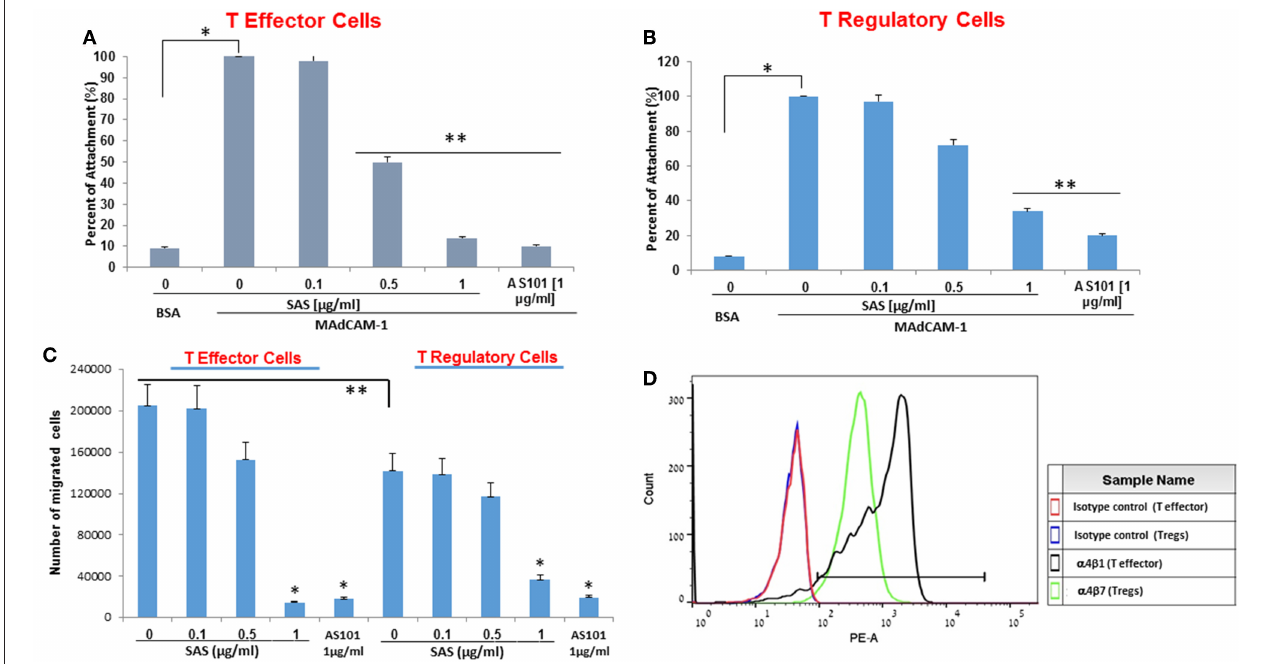
FIGURE 12 | AS101 and SAS inhibit α 4 β 7 integrin activity and α 4 β 7-depenfent migration of T effector cells and Tregs. (A) T effector cells and (B) T regulatory cells were isolated from spleens of 20w old NOD female mice. Cells at 5 × 10 5 /well were incubated in 96 well plates coated with BSA or MAdCAM-1 for 2 hours. Nonattached cells were then washed twice, and the adherent cells were subjected to XTT. The results represent means ± SE of 4 mice/group. * p < 0.001 vs. BSA; ** p < 0.005 vs. MAdCAM-1 alone (SAS 0), (C) T effector cells and T regulatory cells were isolated from spleens of 20w old NOD female mice. Cells (2.5 × 10 5 ) were incubated for 1h in the presence of mobilized MadCAM-1 and various doses of SAS or AS101 and then loaded onto 8mm polycarbonate membrane inserts. The bottom chambers were filled with FBS (20%) and MadCAM-1 (100 µ g/ml) serving as a chemo attractant. Migrated cells were quantified after 24h. The results represent means ± SE of 4 mice/group. * p < 0.001 vs control (SAS 0 of the relevant cell subset). ** p < 0.05 (comparison between controls of both cell subsets). (D) Tregs and T effector cells were isolated from spleens of 20w old female NOD mice and stained for the expression of α 4 β 7. The results represent one experiment representative of three performed with 3